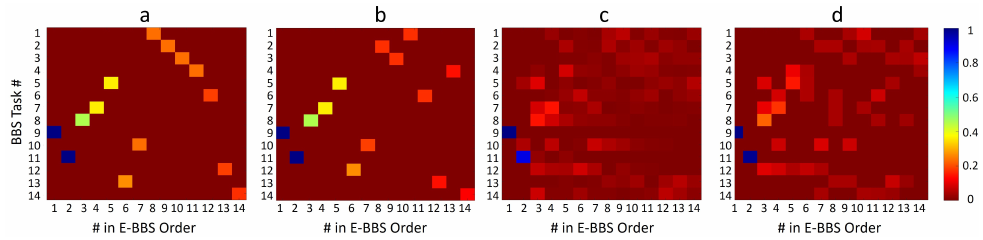
Figure 10. Occurrence matrices depicting the ordering of BBS tasks in the E-BBS. Columns indicate the order in the E-BBS sequence. Each row indicates a standard BBS task as defined in [7]. The matrix entry value indicates the proportion of times a BBS task was used in a certain E-BBS sequence position across the test set. ( a – d ) Occurrence matrices of E-BBS sequences as trained on the physiotherapist data and using the 4 Selector Methods 1 to 4, respectively.